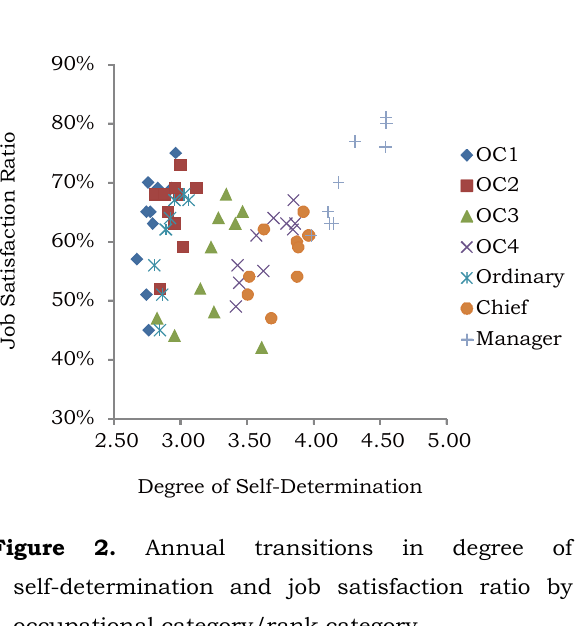
Figure 2. Annual transitions in degree of self-determination and job satisfaction ratio by occupational category/rank